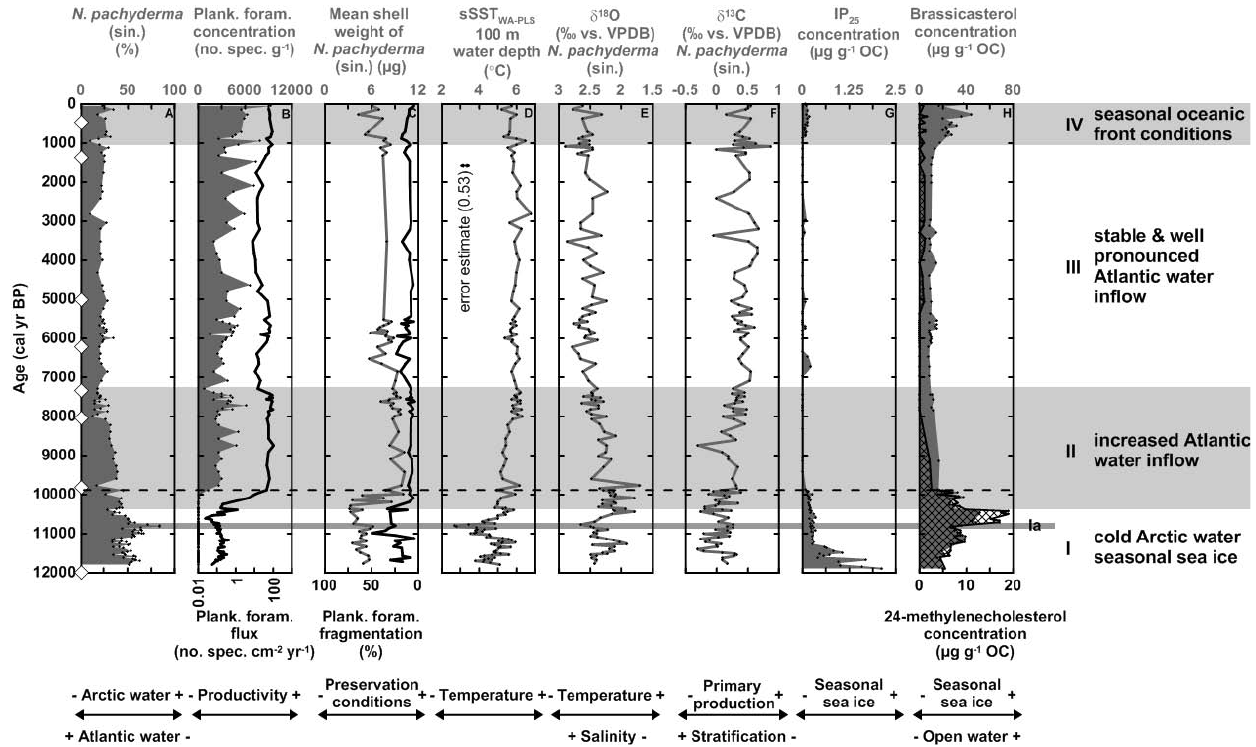
Fig. 7. Summary and palaeoceanographic development interpretation of multi-proxy data plotted versus calyrBP. The white diamonds on the y axis denote the AMS 14 C converted to calibrated radiocarbon ages. Samples below the dotted line contain < 300 planktic foraminiferal specimens. (A) Relative abundance of N. pachyderma (sin.). (B) Planktic foraminiferal concentration (grey-filled area) and total planktic foraminiferal flux (black line) (note the logarithmic scale for the flux). (C) Mean shell weight of N. pachyderma (sin.) (grey line) and planktic foraminiferal fragmentation (black line) (note the reversed axis). (D) Reconstructed summer sea surface temperature estimates. (E) δ 18 O measurements of N. pachyderma (sin.) corrected for ice volume effect after Fairbanks (1989). (F) δ 13 C measurements of N. pachyderma (sin.). (G) Seasonal sea ice biomarker IP 25 concentration normalized against organic carbon. (H) Sterol concentration normalized against organic carbon: brassicasterol (grey-filled area) and 24-methylenecholesterol (black-hatched